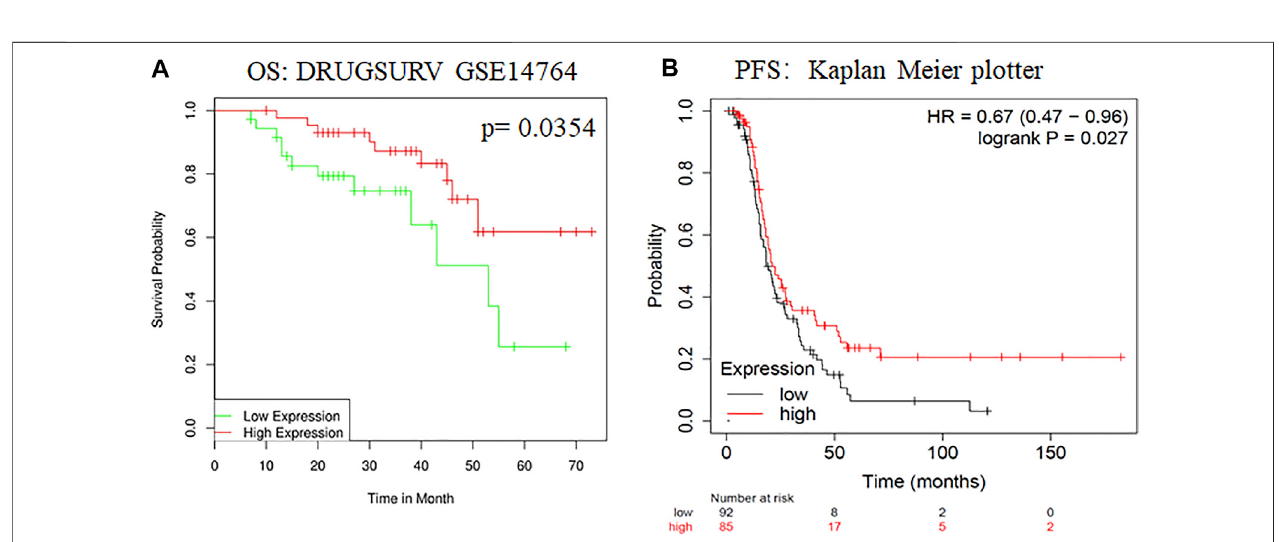
FIGURE 2 | The effects of ADARB1 expression on the prognosis of OC patients. (A) The relationship between ADARB1 expression and OS analyzed by DRUGSURV database. (B) The relationship between ADARB1 expression and PFS analyzed by Kaplan – Meier Plotter.